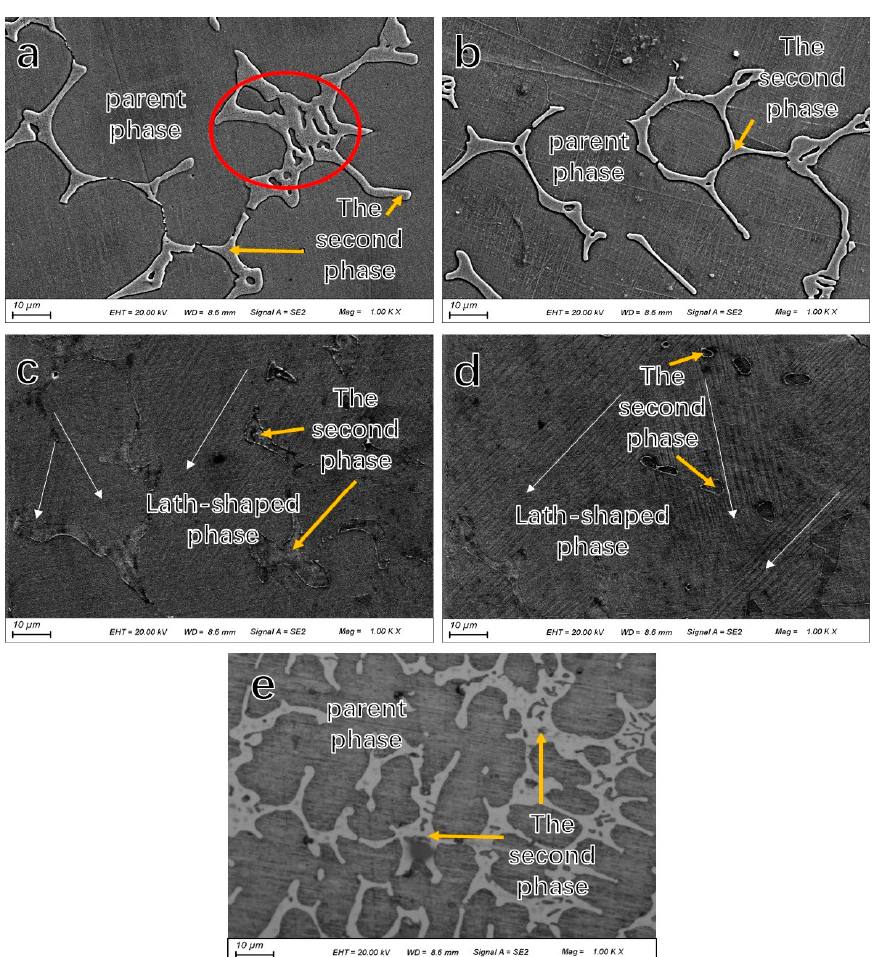
Figure 2. Morphology of microstructures in Co 33 Ni 31 Al 27 Fe 9 alloy with furnace cooled and rapid solidification (RS): ( a ) furnace cooled; ( b ) D8; ( c ) D4; ( d ) D1; and ( e ) the sample after annealing.